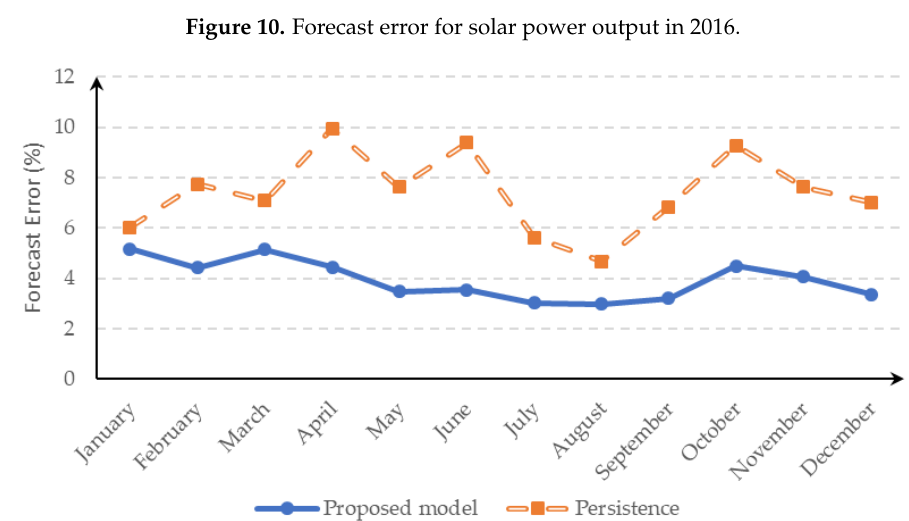
Figure 11. Monthly NMAE of each forecasting method for solar power output in 2016. Table 6. NMAE for each month of forecasting in 2016.